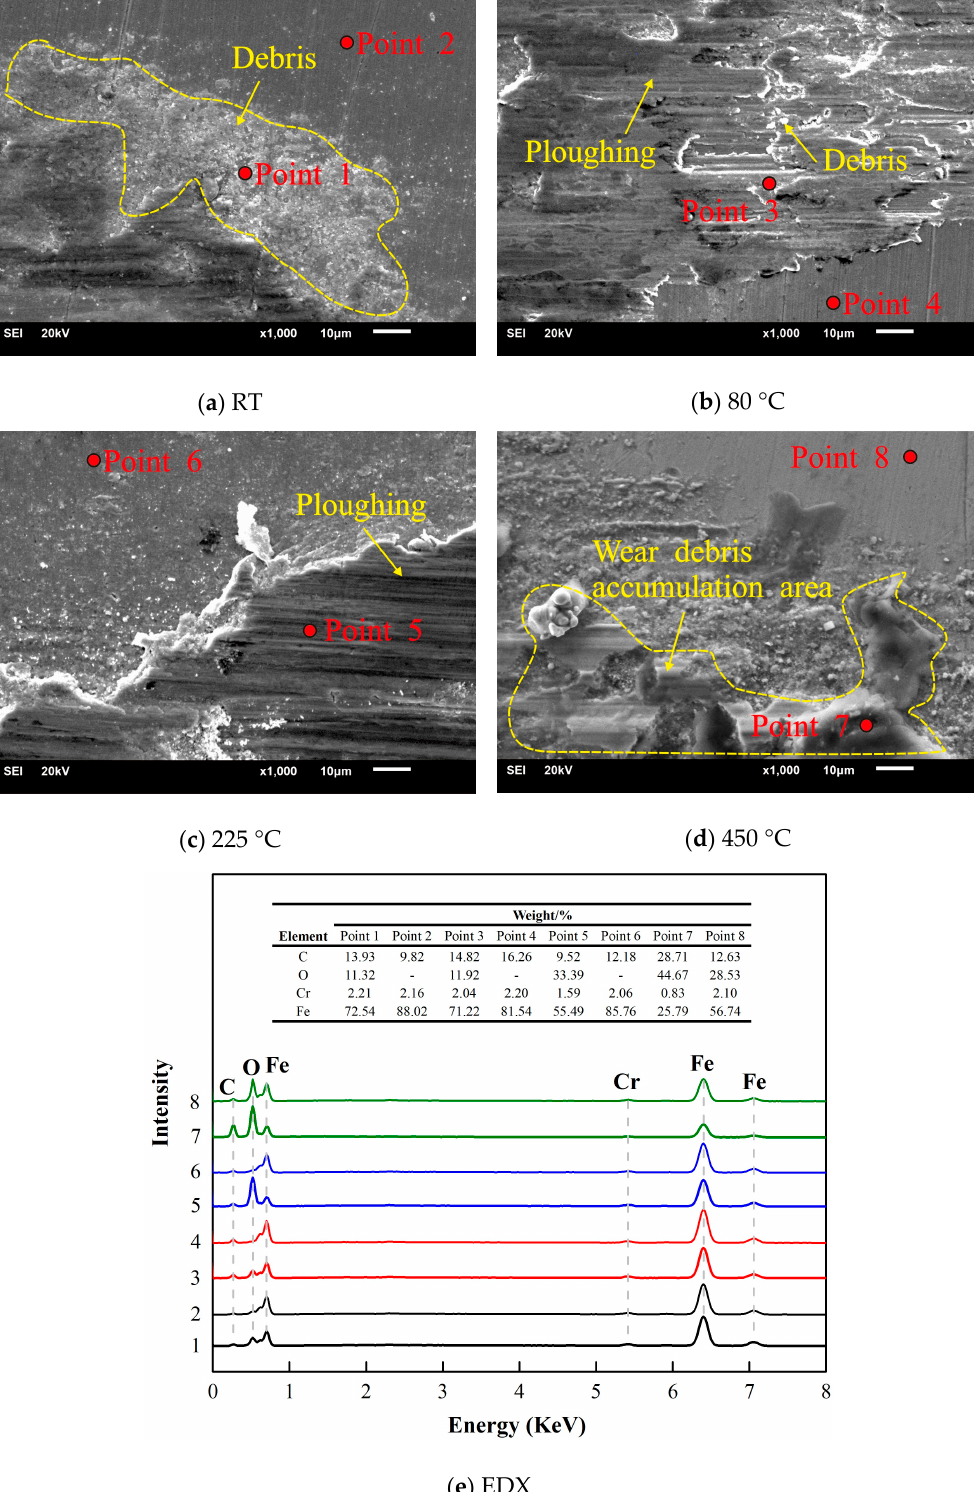
Figure 8. SEM micrographs and EDX of worn scars, D = 50 μ m, F = 10 N.